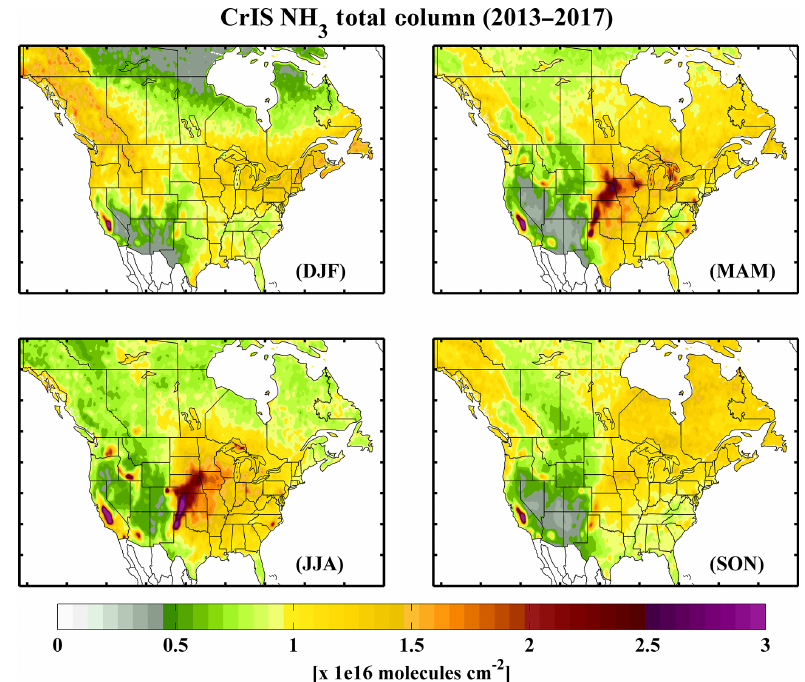
Figure C2. Similar to Fig. 8 but for total column